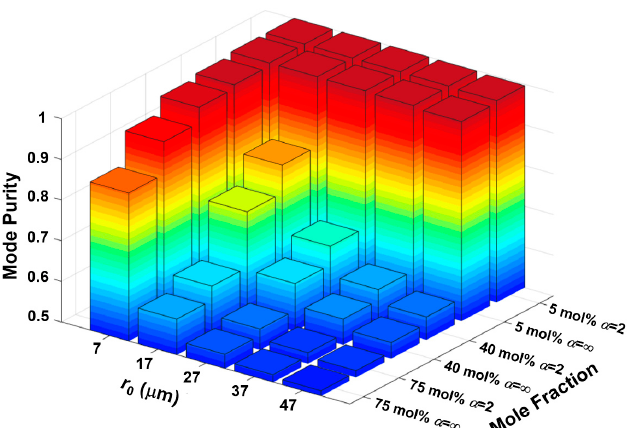
Figure 8. OAM mode purity based on HE 2,1 eigenmodes as a function of the position of ring-core for different GeO 2 mole fractions.